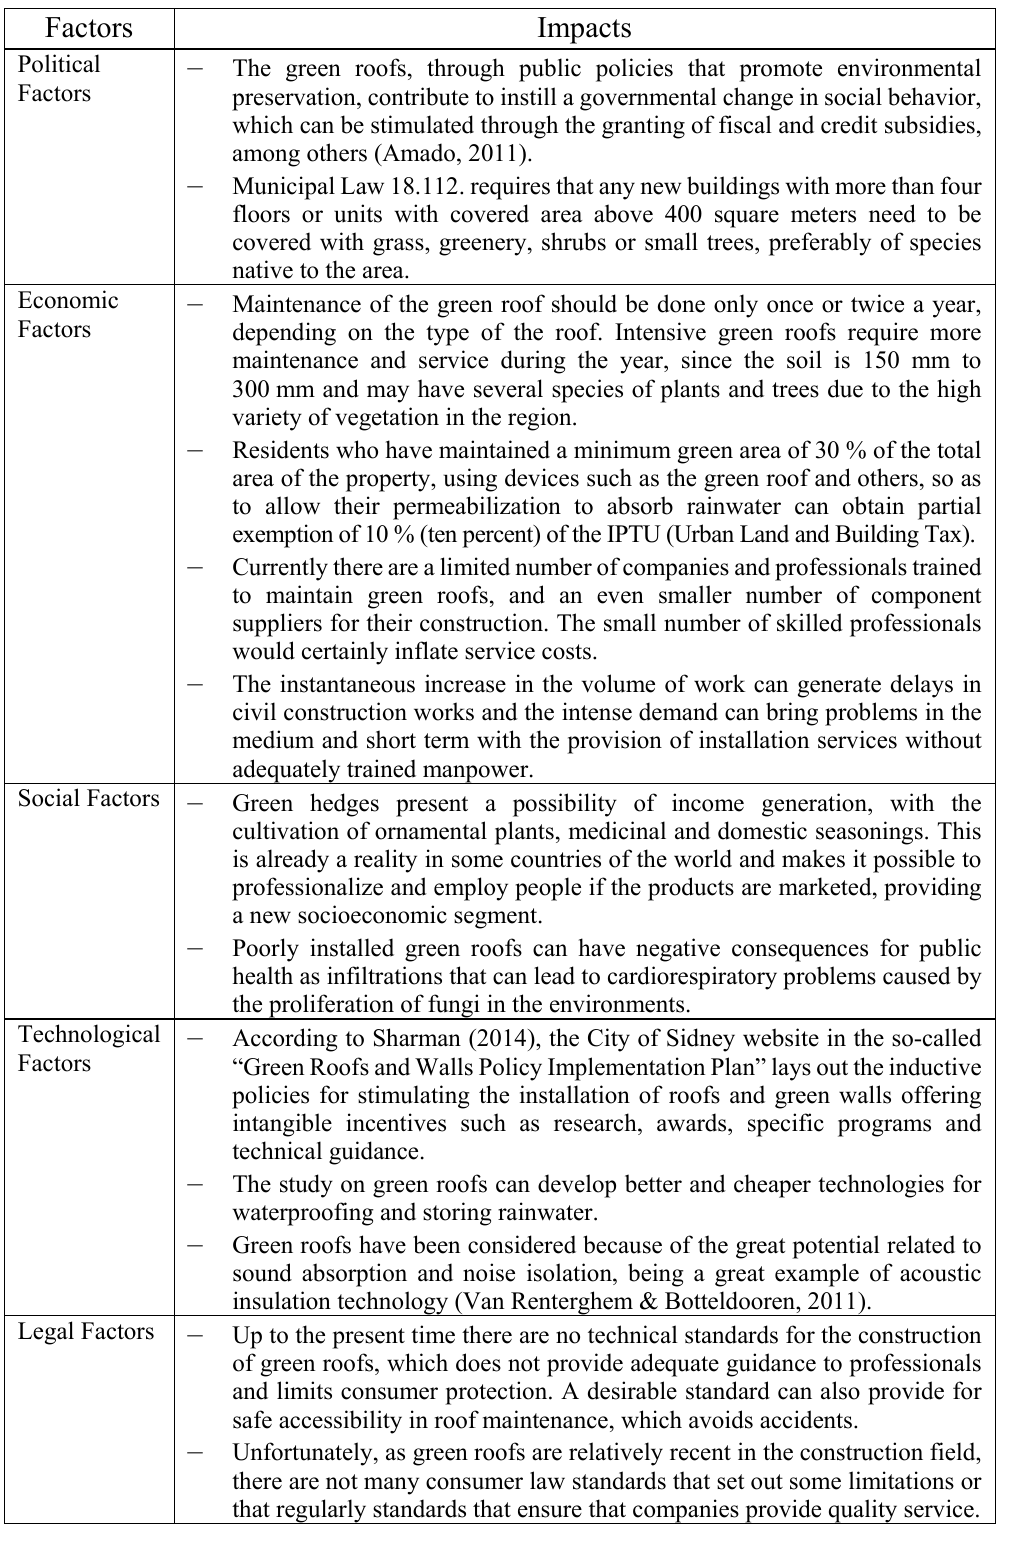
Table 1. Factors and Impacts Caused by Green Roofs within External Factor Analysis [table compiled by the